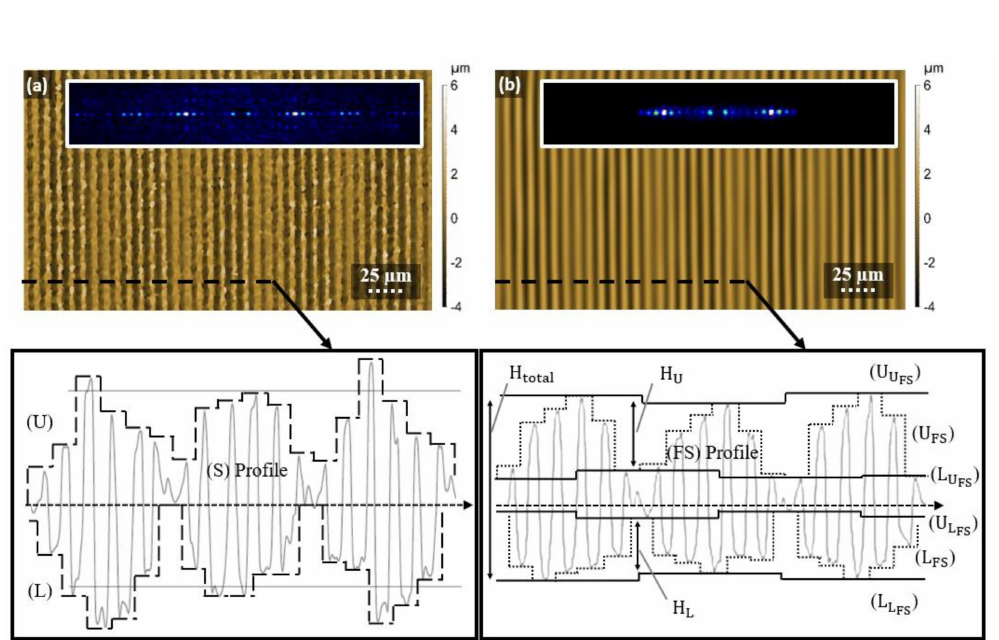
Figure 3. Topography images of ( a ) measured DLIP surface and ( b ) filtered surface with corresponding roughness profiles. The insets show Fourier transform of each of the